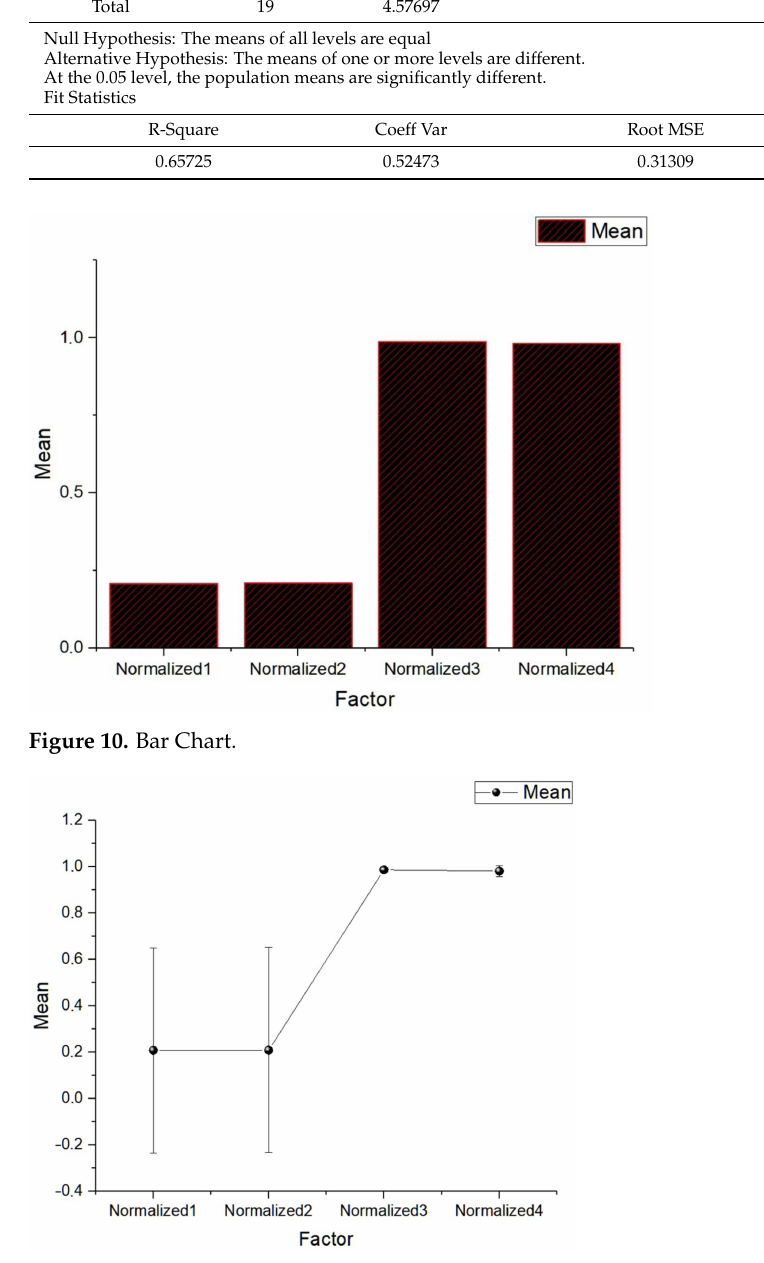
Figure 11. Means Plot SD (as